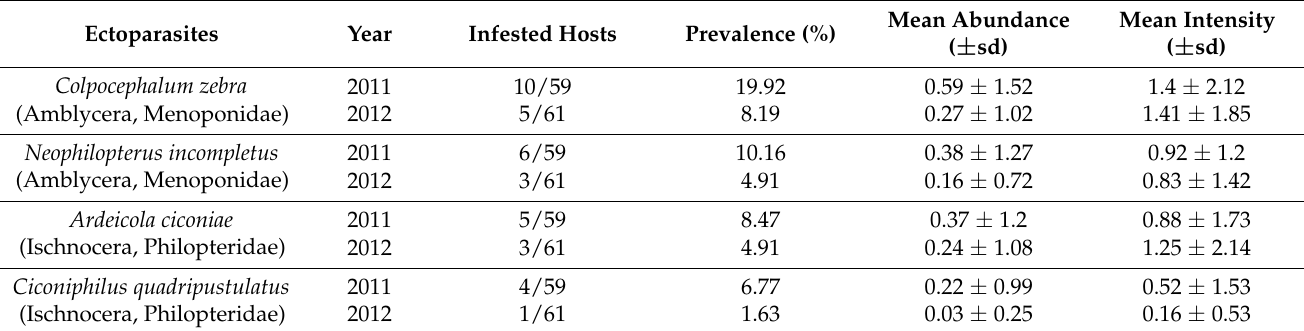
Table 1. Feather lice collected from white stork nestlings at Dr é an (2011 and 2012) with prevalence, mean abundance and mean intensity of